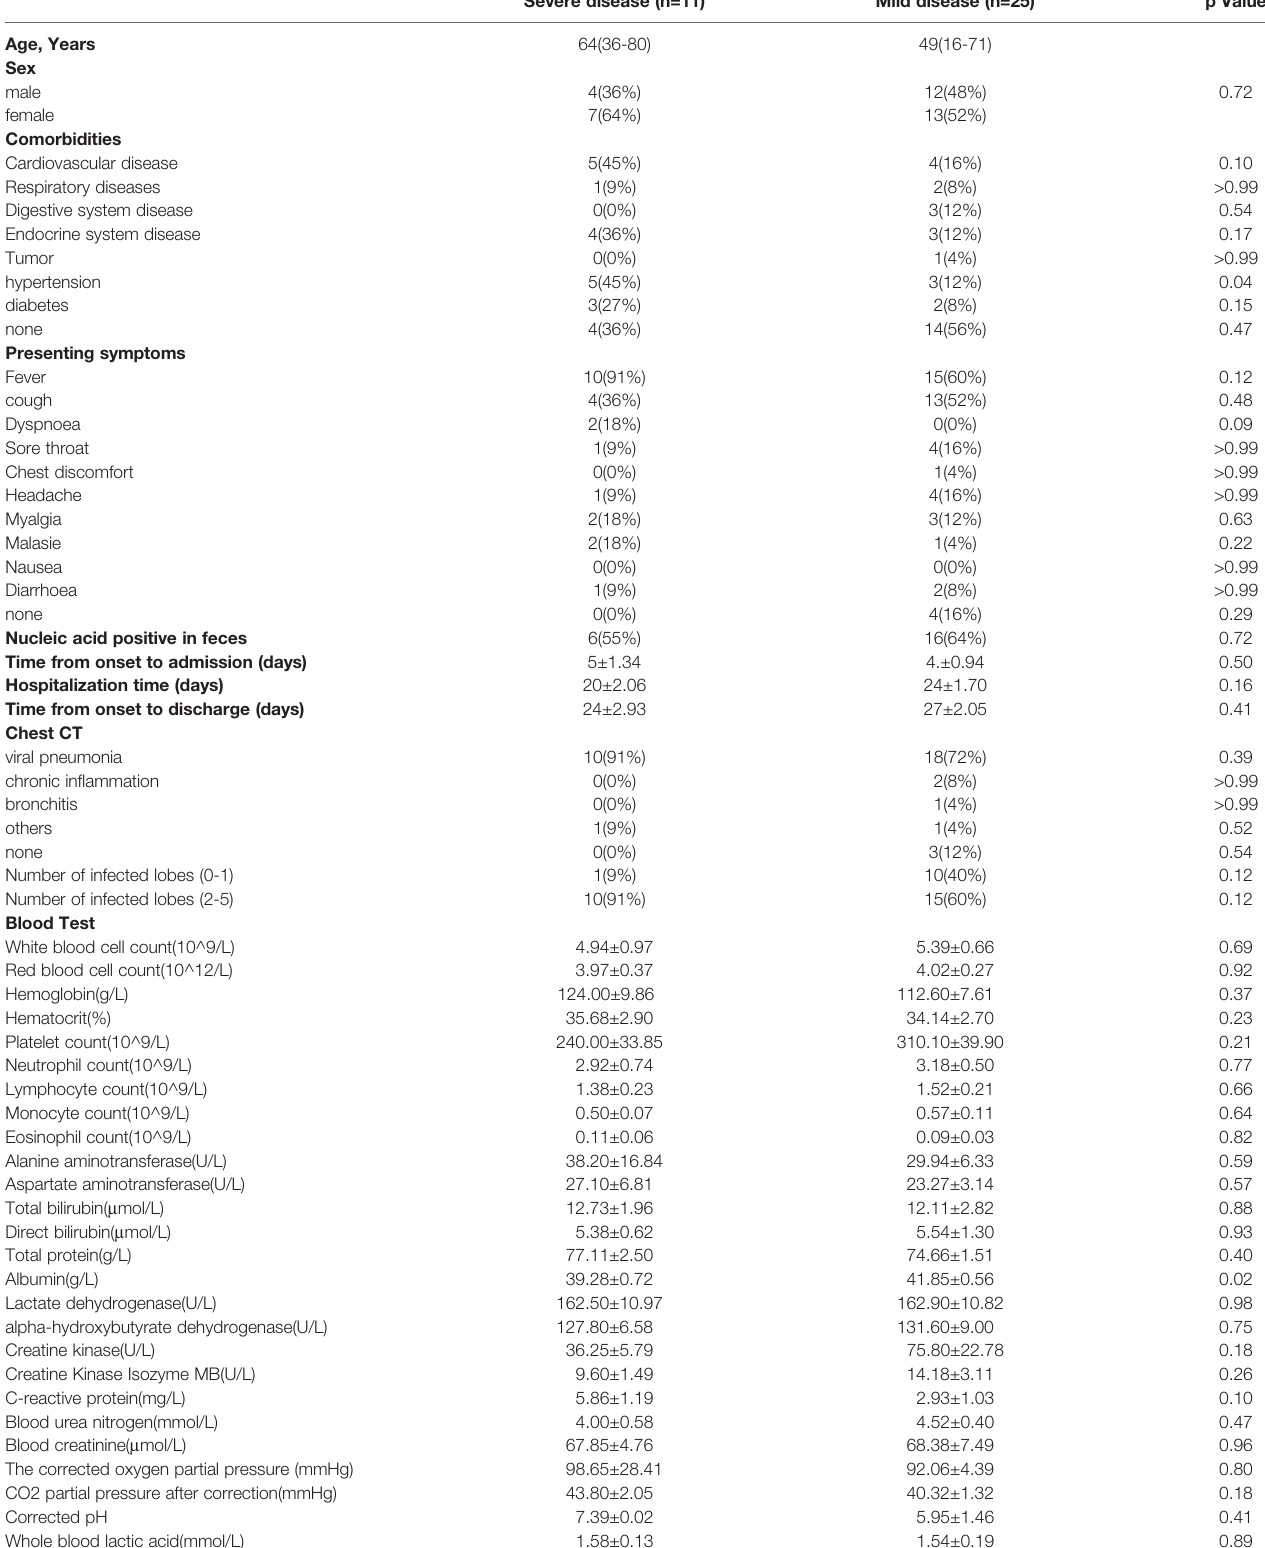
TABLE 2 | Clinical characteristics of COVID-19